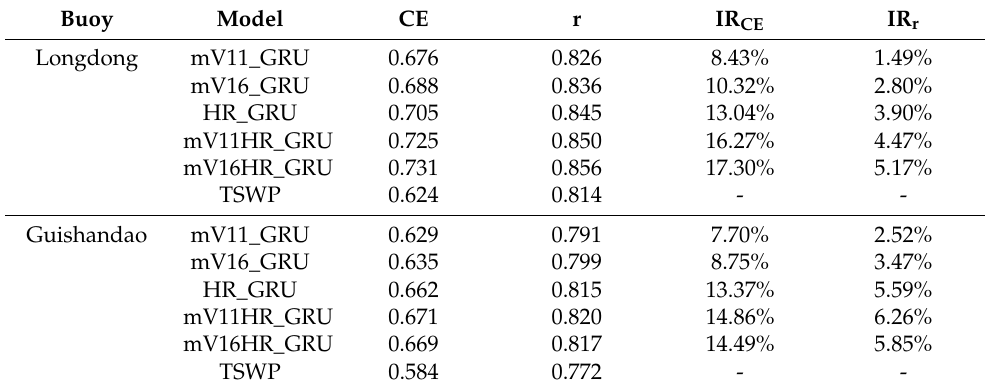
Guishandao buoys.